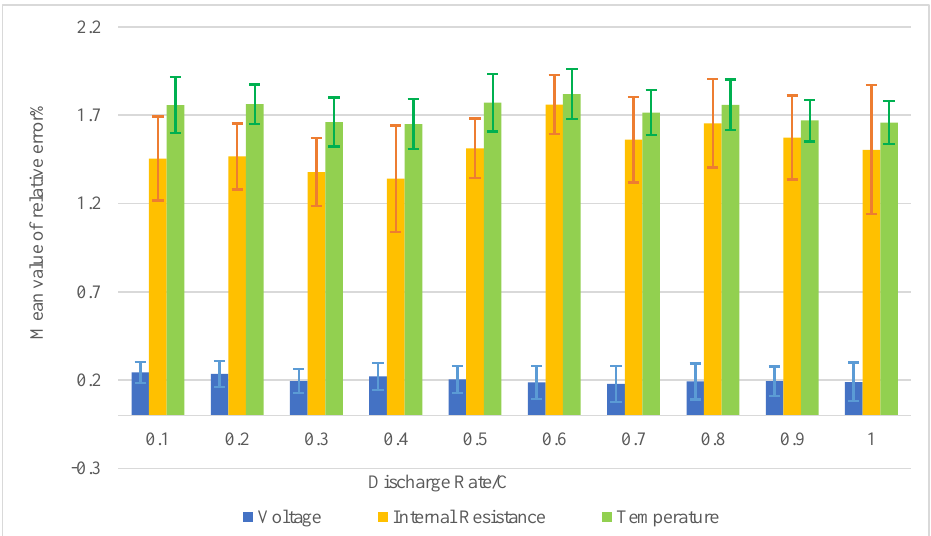
Figure 15. The statistics of the average relative error of each parameter measurement in the experiment.